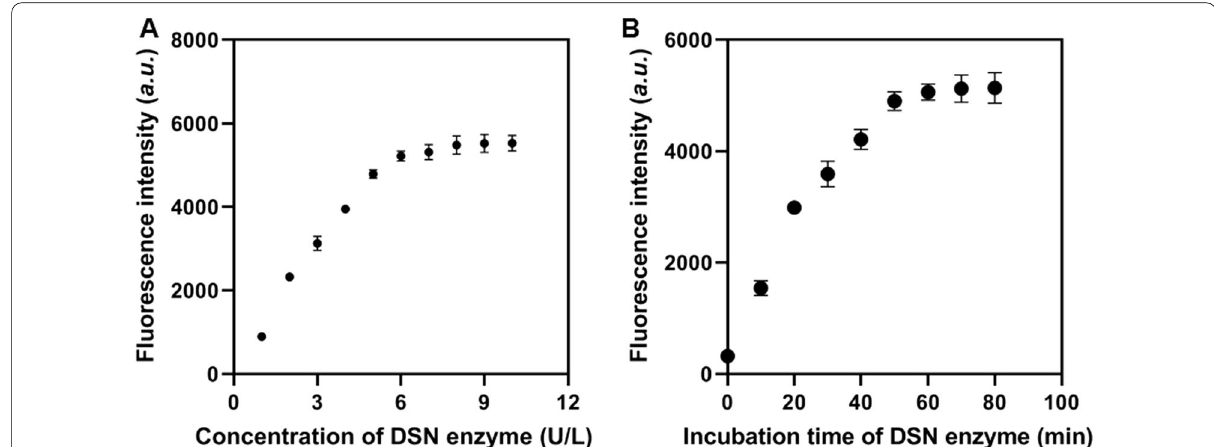
Fig. 4 Optimization of experimental conditions. A Fluorescence signal of the approach with different concentrations of DSN enzyme. B Fluorescence intensity of the approach with different incubation time of DSN